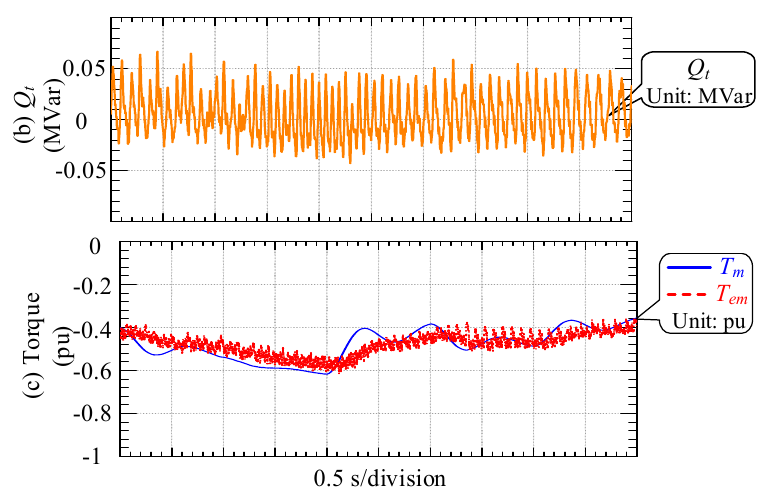
Figure 15. ( a ) Output active power P t ; ( b ) output reactive power Q t ; and ( c ) the mechanical torque T m and electromagnetic torque T em with wind speed fluctuation.